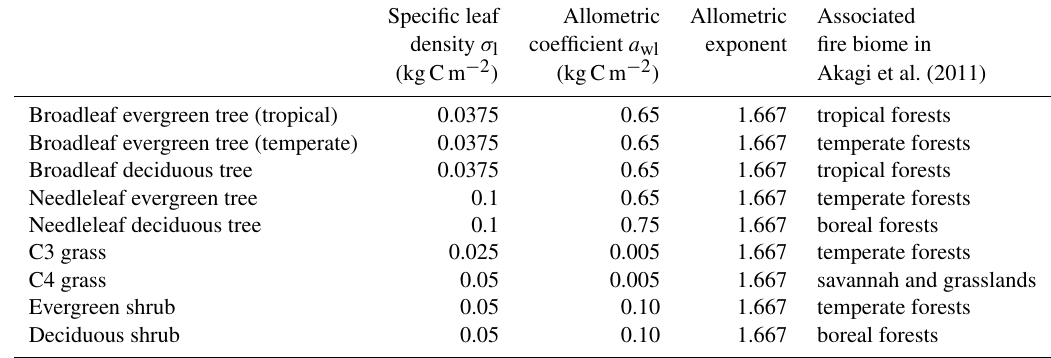
Table A1. The key JULES PFT-specific parameters for allometry and vegetation carbon used in our simulations (Clark et al., 2011). Specific leaf Allometric Allometric